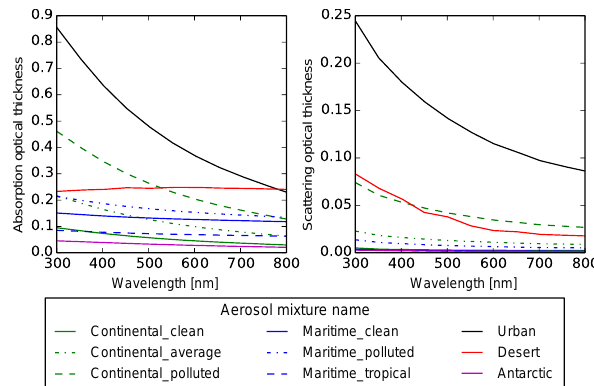
Figure 4. Absorption (left) and scattering (right) optical thick- ness for various aerosol mixtures specified using the option aerosol_species_file . The aerosol optical properties as well as the mixtures have been generated based on OPAC (Hess et al., 1998)